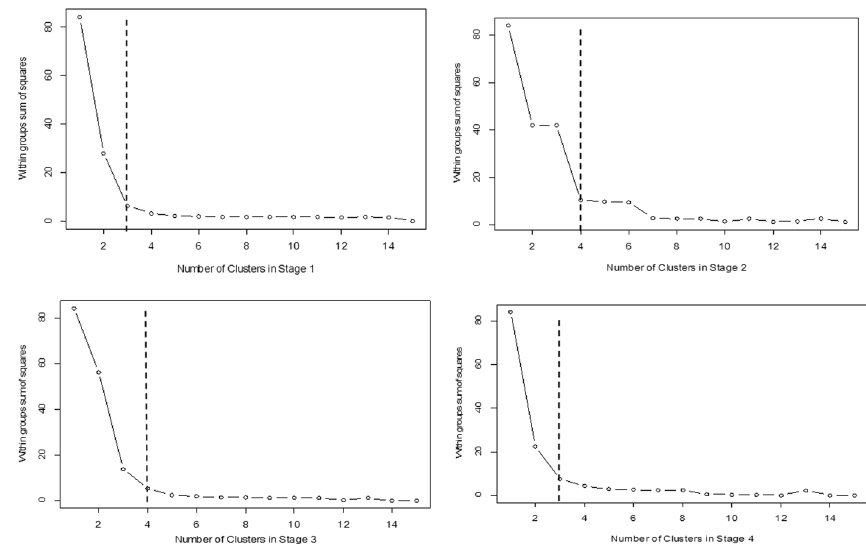
Fig. 13 Number of clusters k with spatial correlations (Moran’s I) by stage